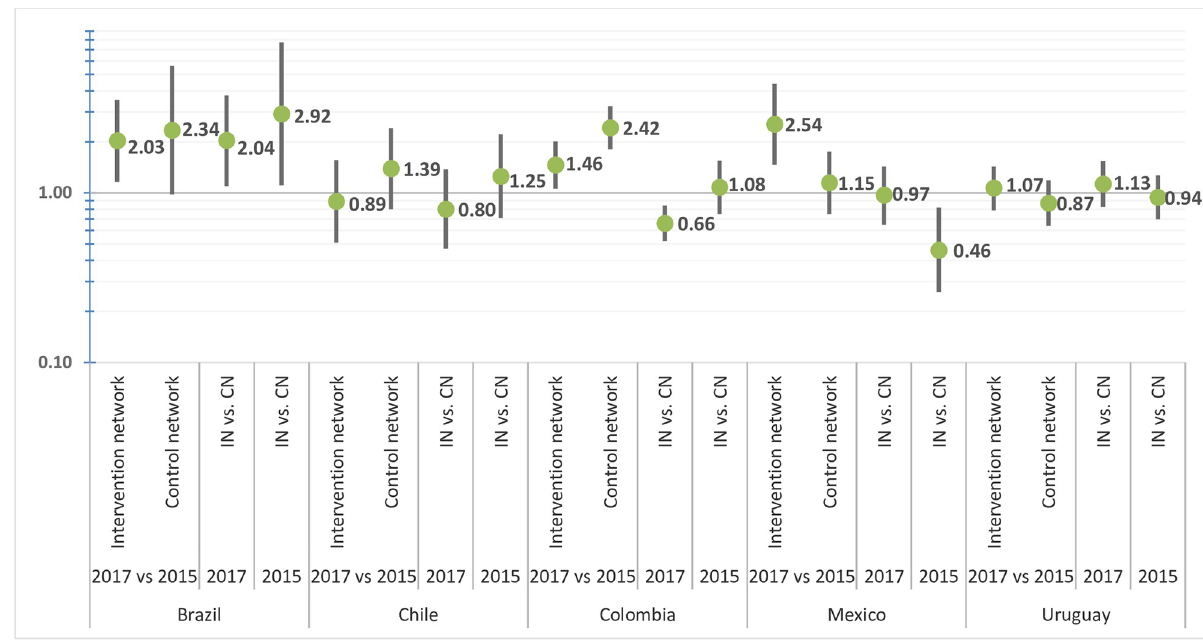
Fig 1. Changes in general perception of care coordination between 2015 and 2017 in the intervention and control networks, by country. Results from the Poisson regression models with robust variance adjusted for sex, age and healthcare level. IN : intervention network. CN : control network.